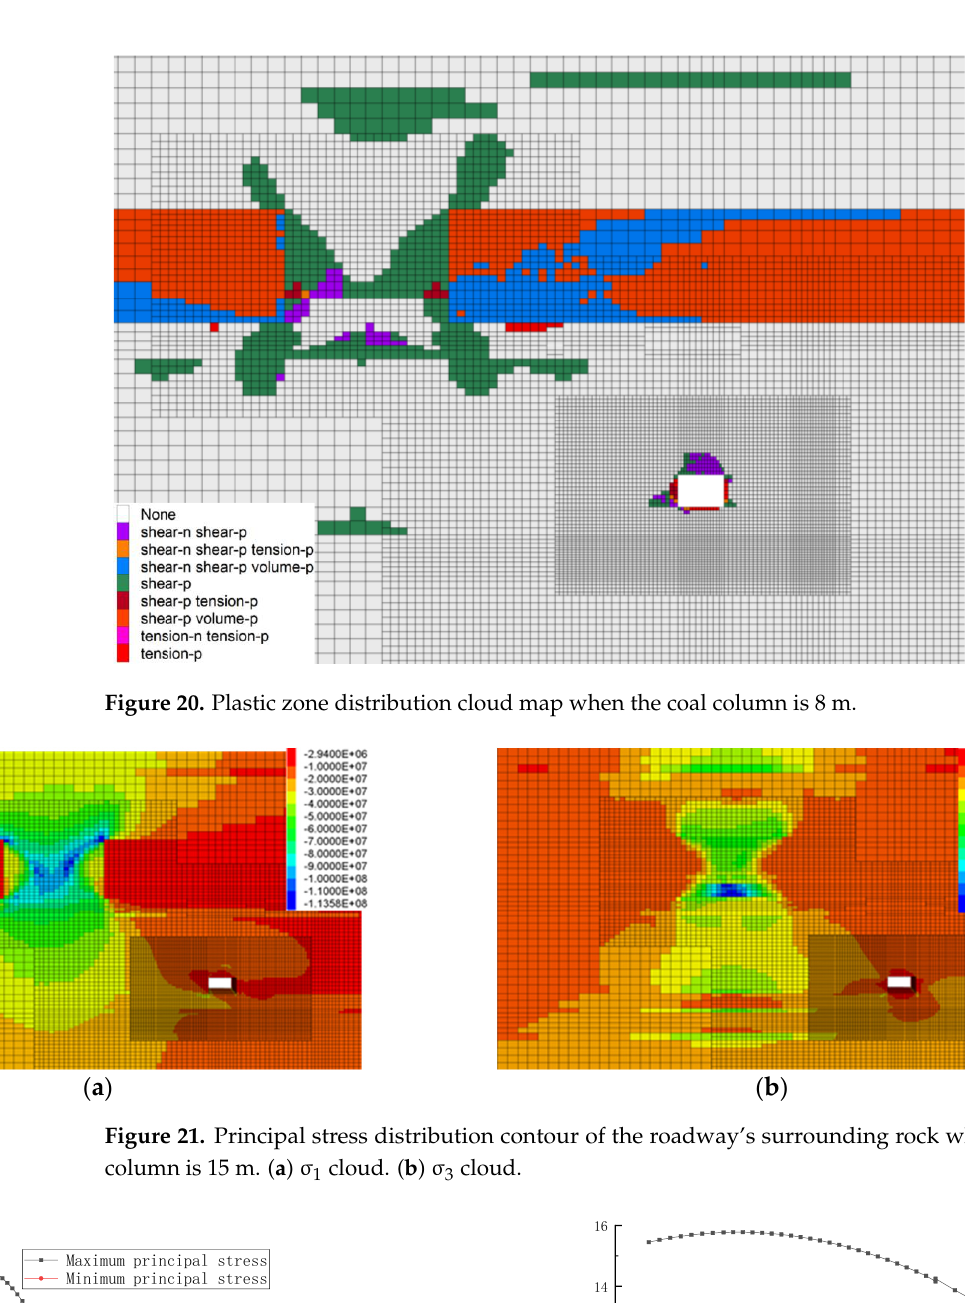
( b ) Figure 19. Changes in the principal stresses of the roadway ’s surrounding rock when the coal col- umn is 8 m. ( a ) Horizontal direction. ( b ) Variation direction.